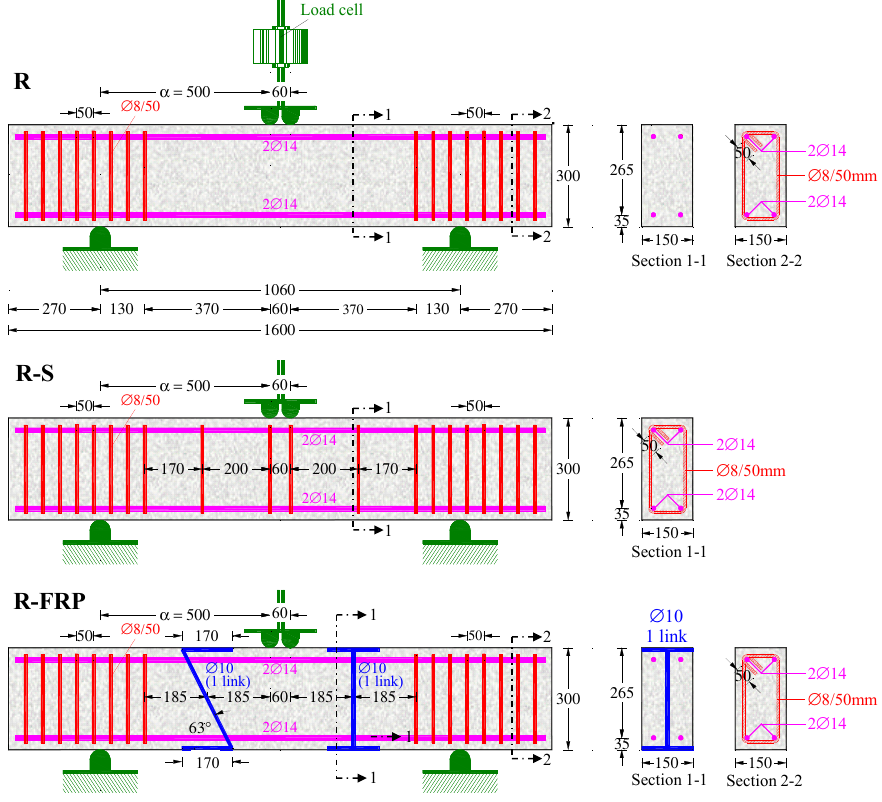
Figure 1. Geometry and reinforcement details of the beams with rectangular cross-sections.